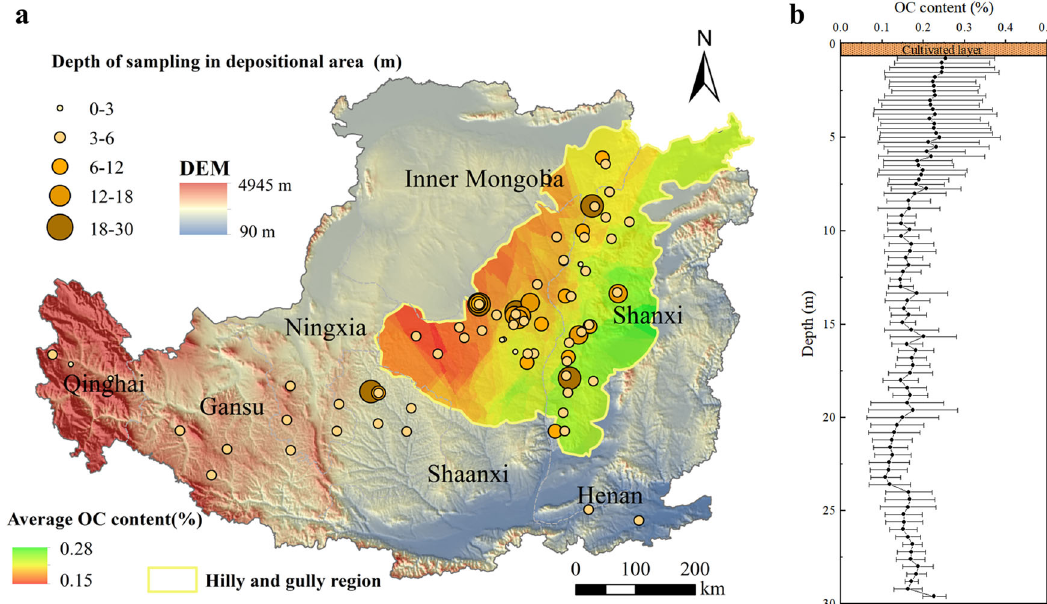
Fig. 5 Spatial and vertical distribution characteristics of carbon buried in check dams. a Spatial distribution of OC contents. Note: we only carry out Kriging interpolation in the hilly and gully region with the highest density of check dams and sampling points. (See Supplementary Note 3). b Average vertical distribution of OC content of all 86 deep sediment cores. Error bars represent standard